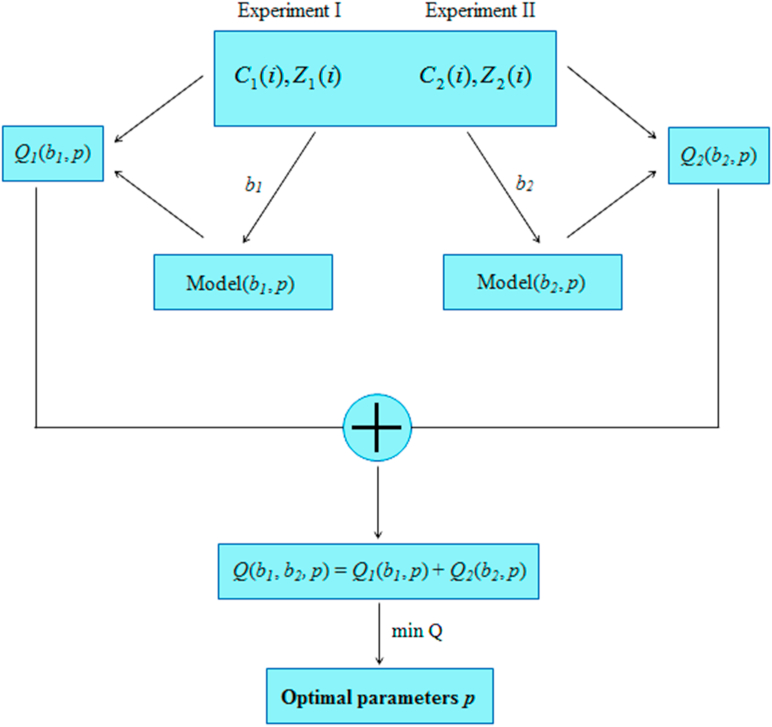
Block scheme of the parameter identification algorithm.